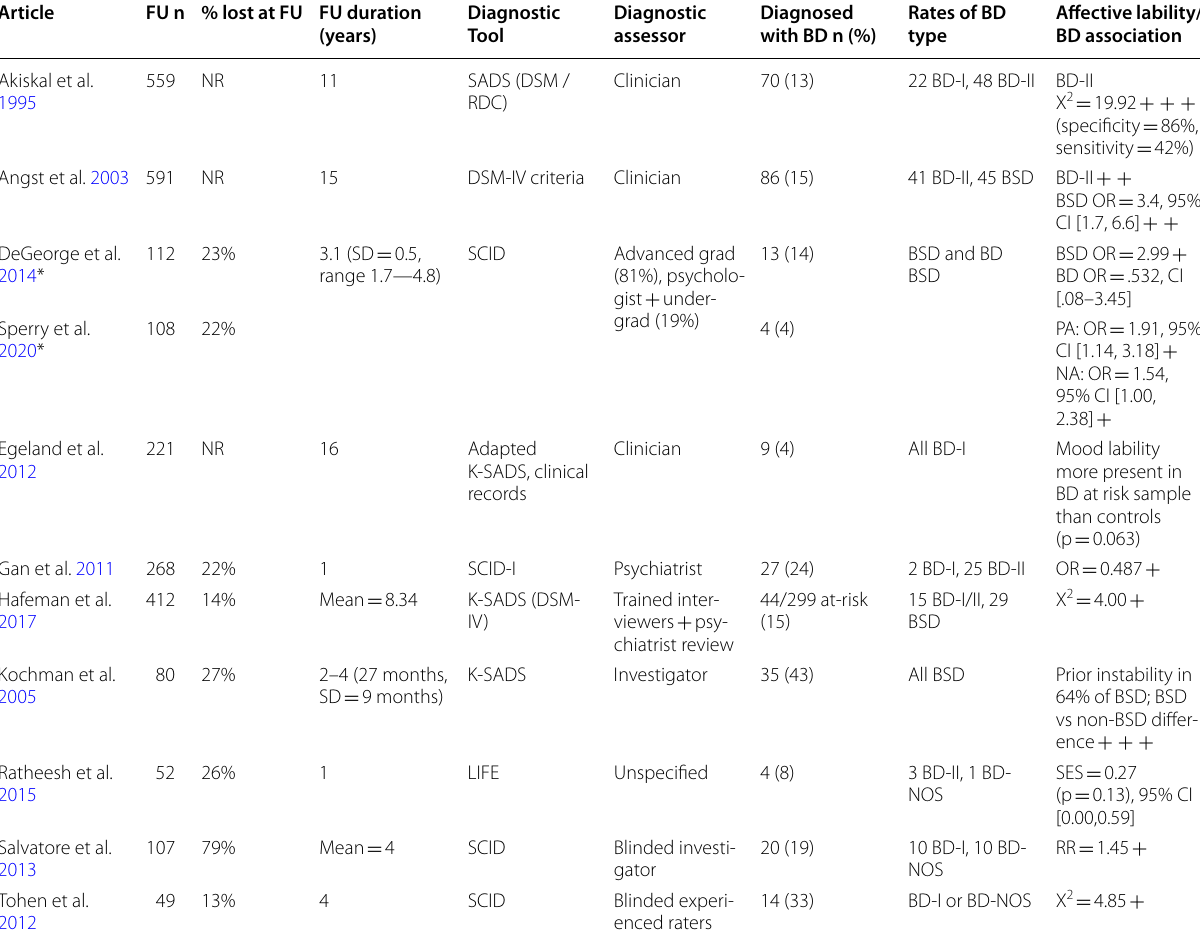
Table 2 Study characteristics and findings at